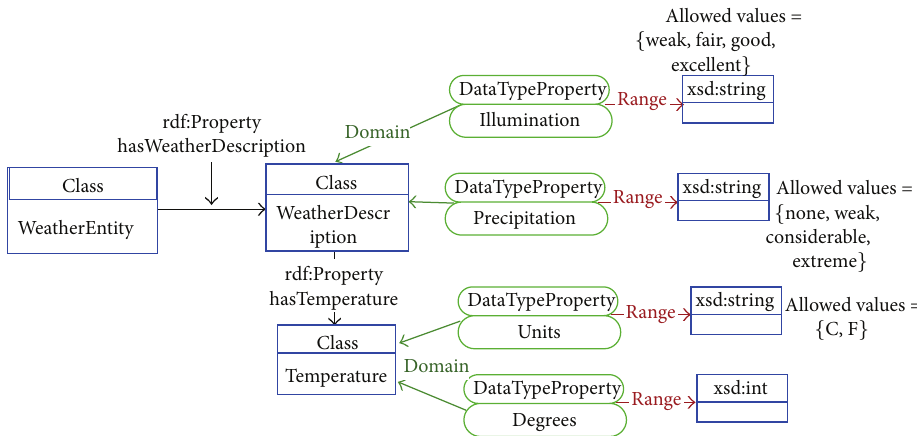
Figure 7: Conceptual diagram of information to characterize the weather context associated with the physical activity.